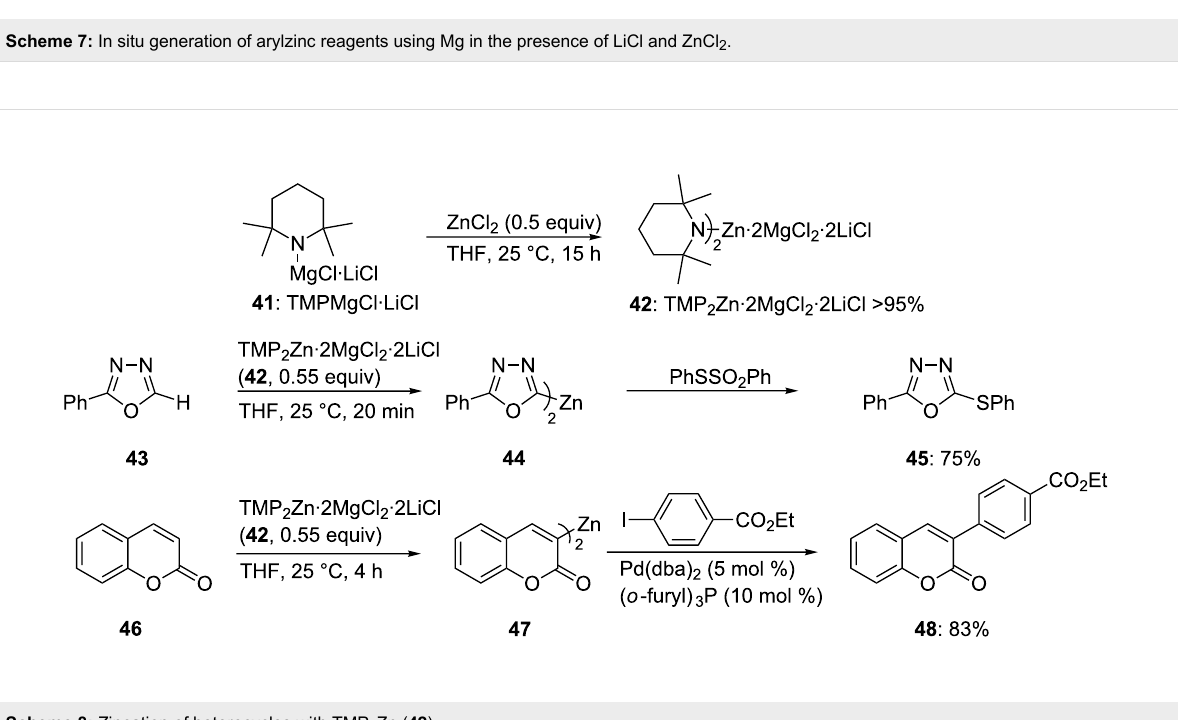
Scheme 8: Zincation of heterocycles with TMP 2 Zn ( 42